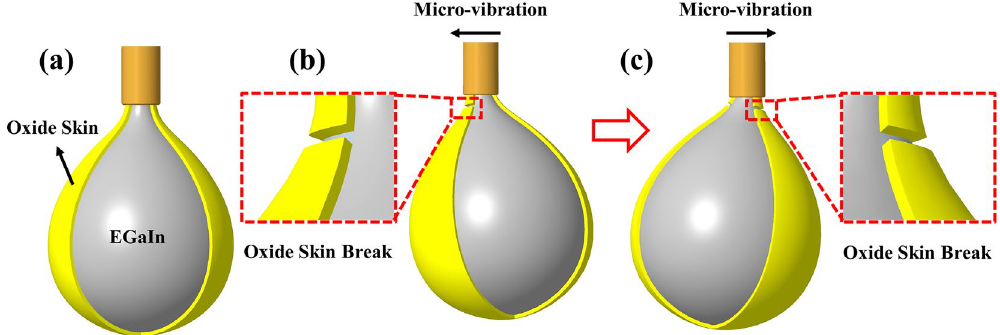
Figure 1. Principle of micro-vibration piercing oxide skin. ( a ) EGaIn forms a core–shell structure in air. ( b , c ) Micro-vibrations cause the oxide skin to